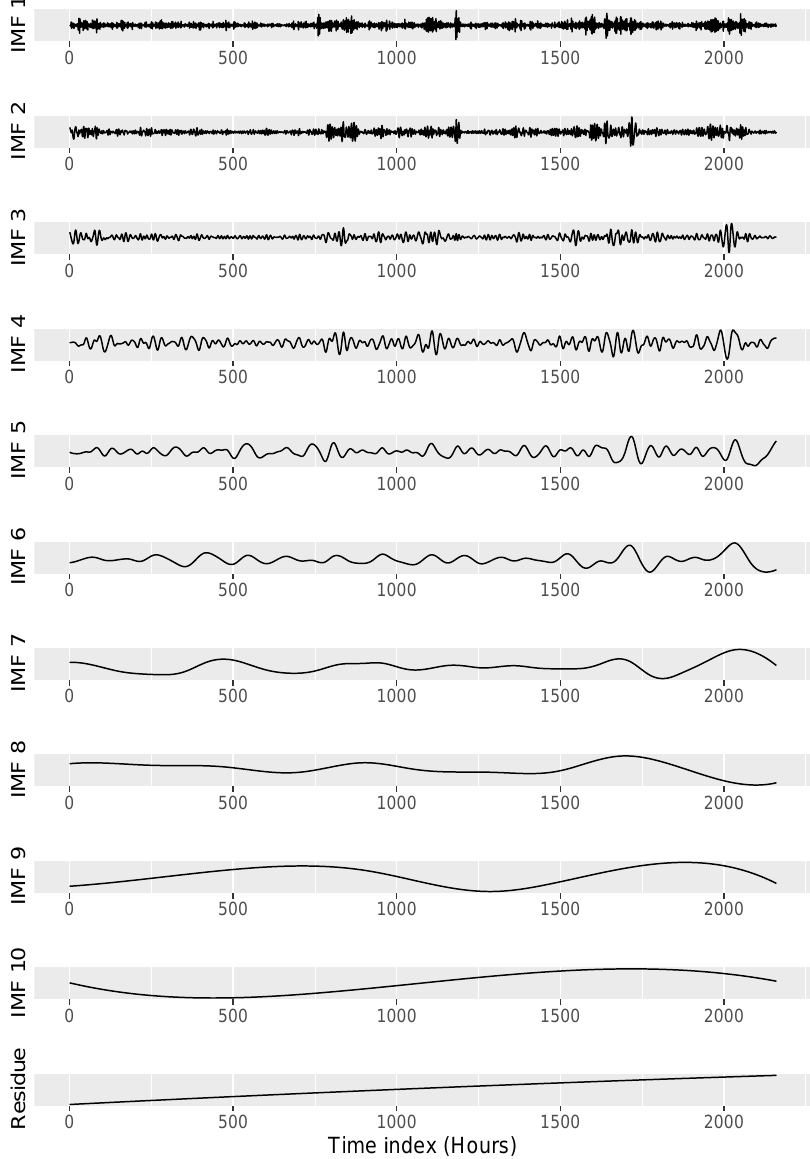
Figure 7. The decomposition of mean wind speed time-series (sampled at 10 min) by EEMD